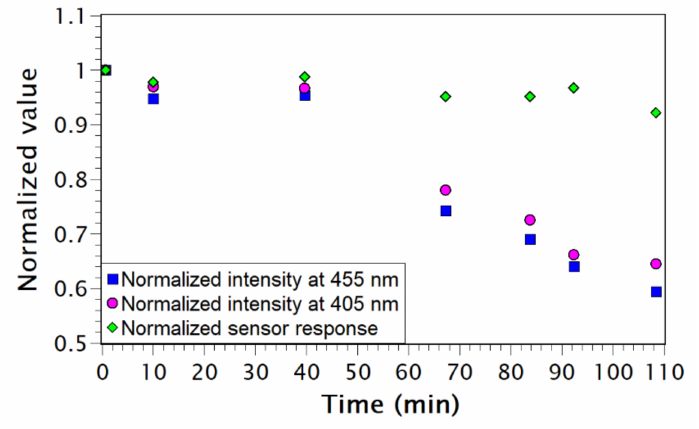
Figure 8. Decrease of the measured intensities and the sensor response for pH = 7.0 in time.